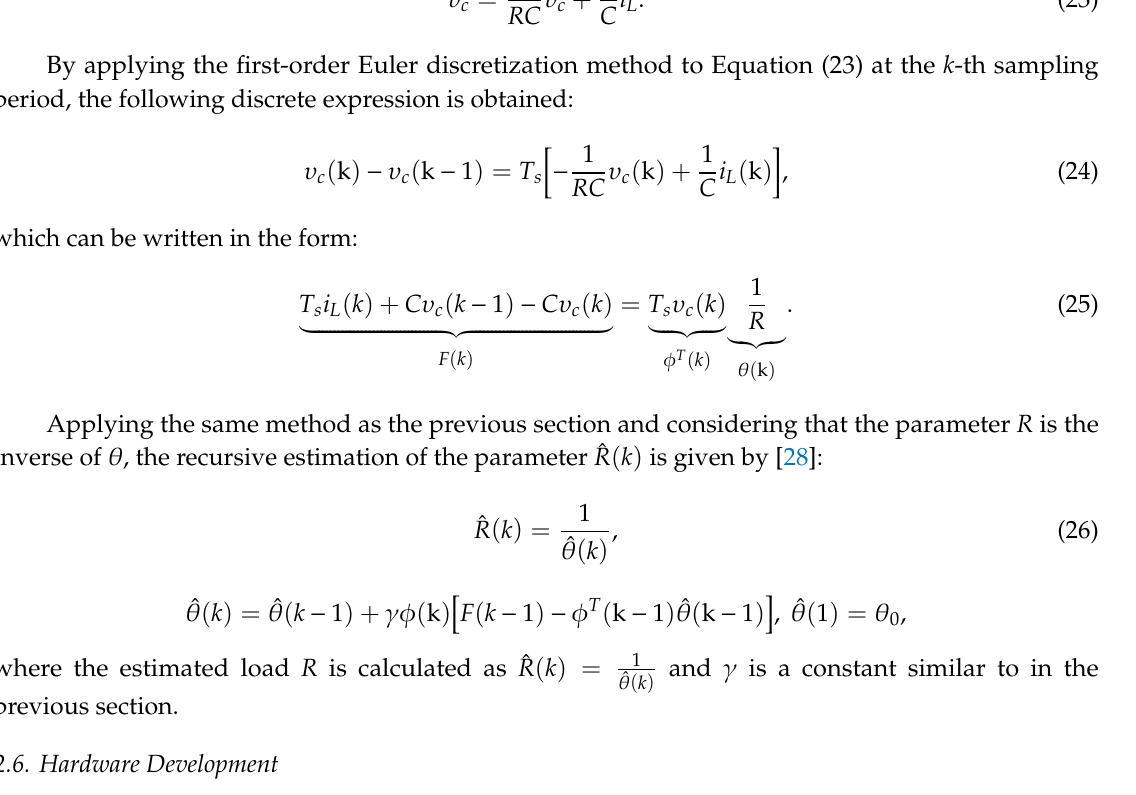
Figure 6. Hardware implemented for the analogic circuit.